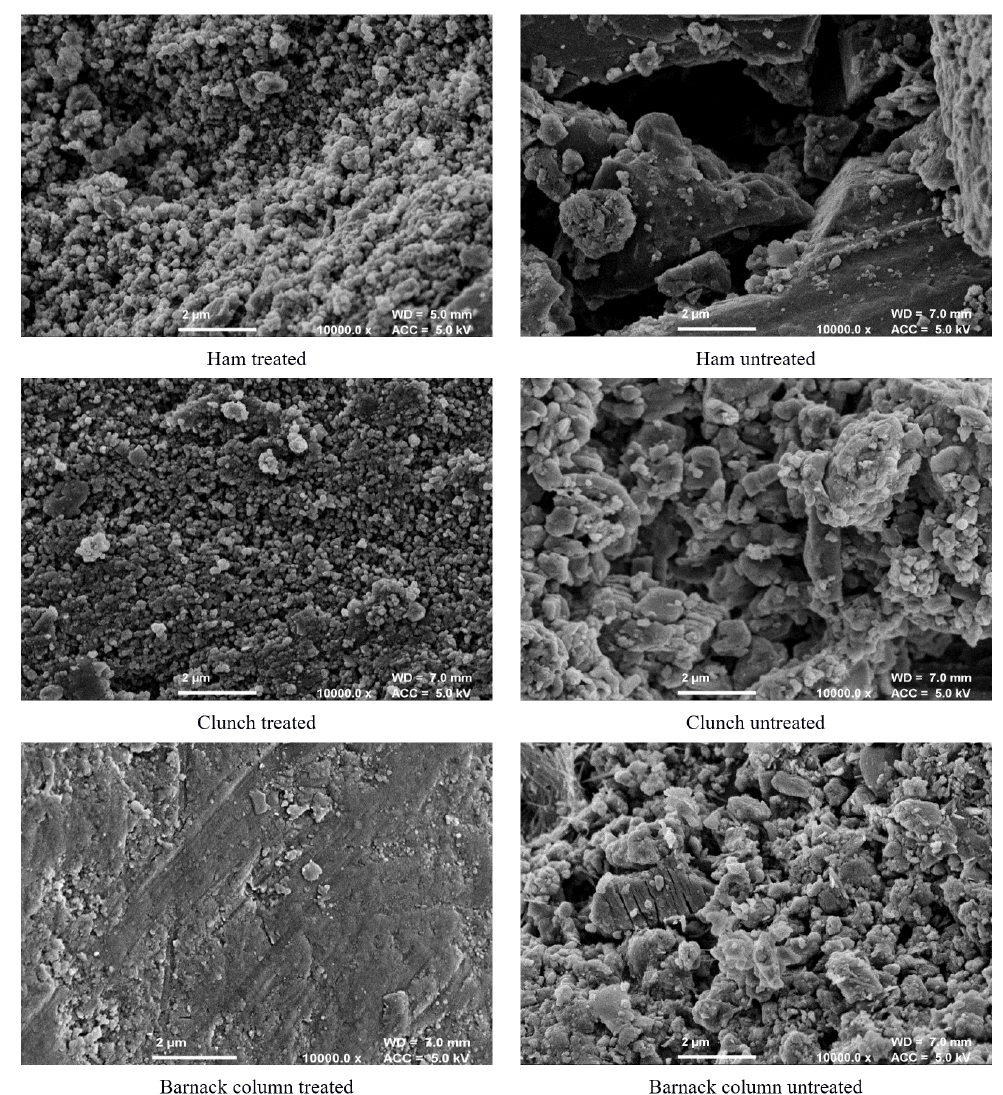
Figure 3. FESEM images of the Ham, Clunch and Barnack column stone